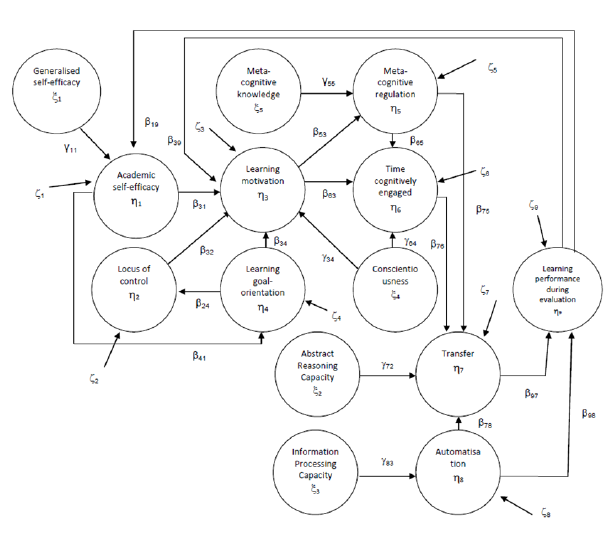
Figure 1: The hypothesised Van Heerden - De Goede expanded learning potential structural